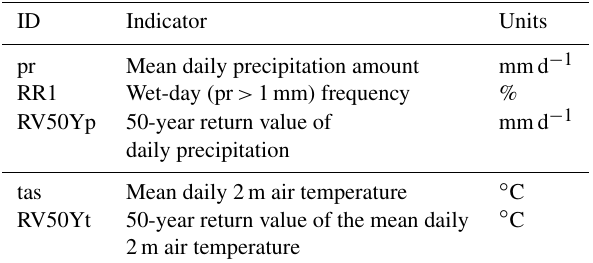
Table 1. Precipitation and temperature indices used in this study. ID Indicator